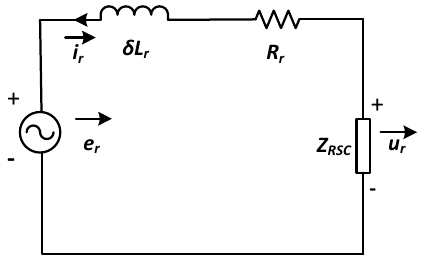
Figure 7. Equivalent circuit of DFIG viewed from the rotor side.